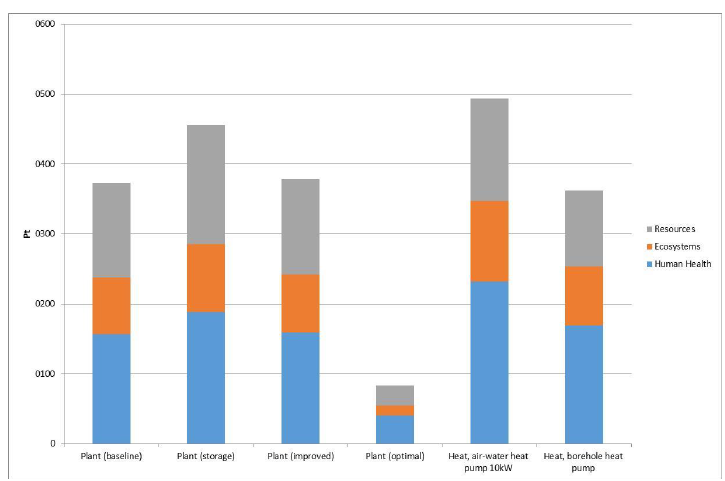
Figure 4. Endpoint indicators of all the analyzed scenarios.